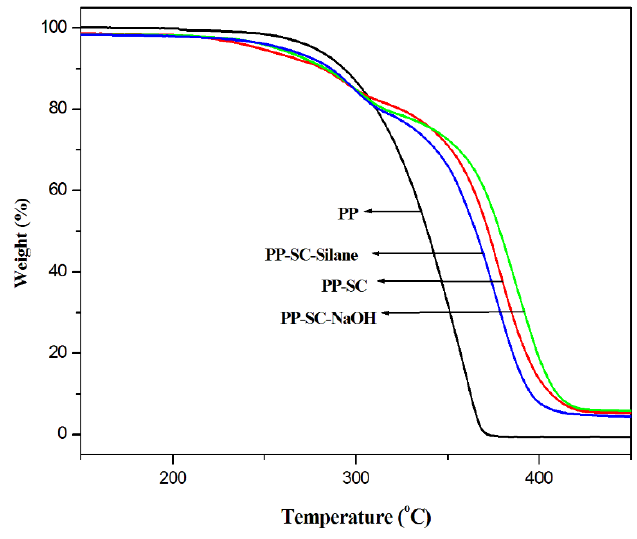
Figure 3. TGA curves of PP, PP-SC, PP-SC-NaOH and (b) PP-SC-silane composites.